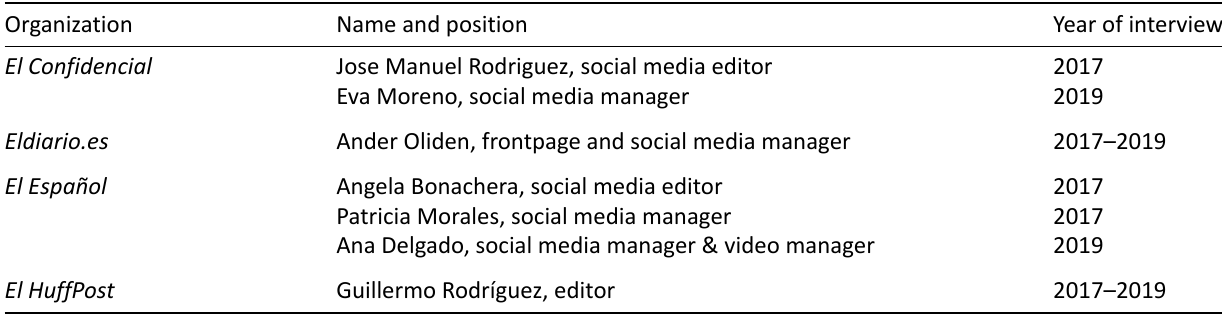
Table 1. List of